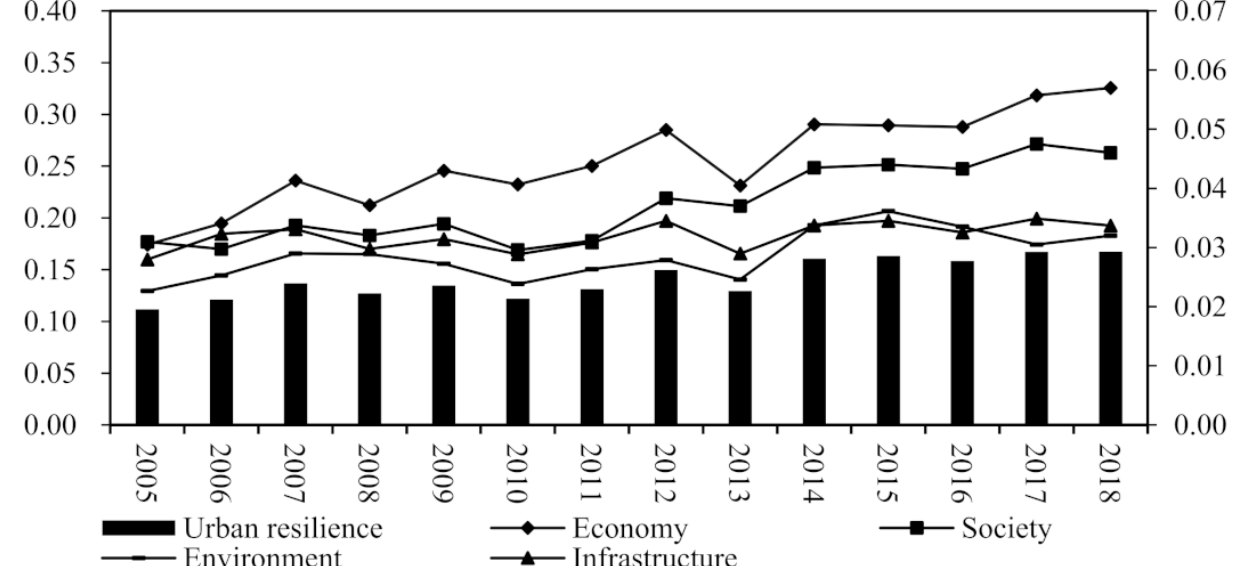
Figure 2. Change trend of urban resilience and mean value of fractal